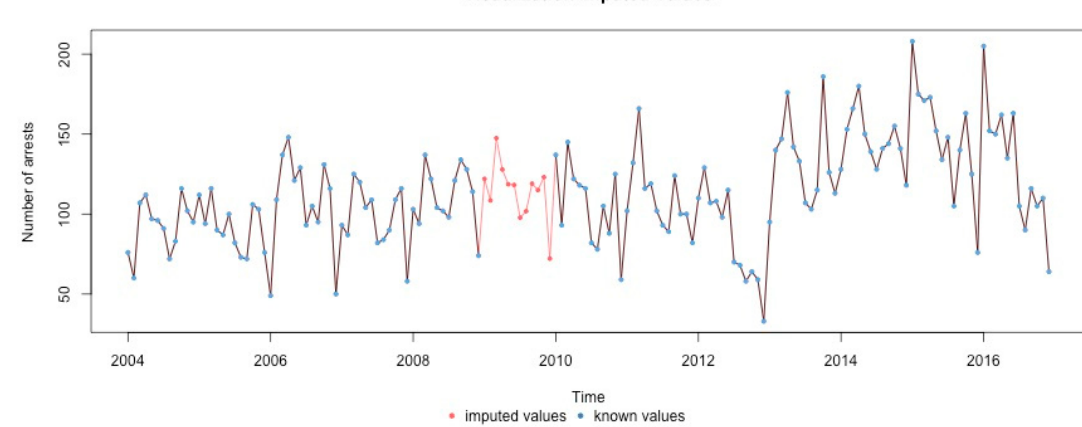
Figure A2. Methamphetamine Czech nationals arrests 2004–2016 in the Czech Republic—imputed missing values.